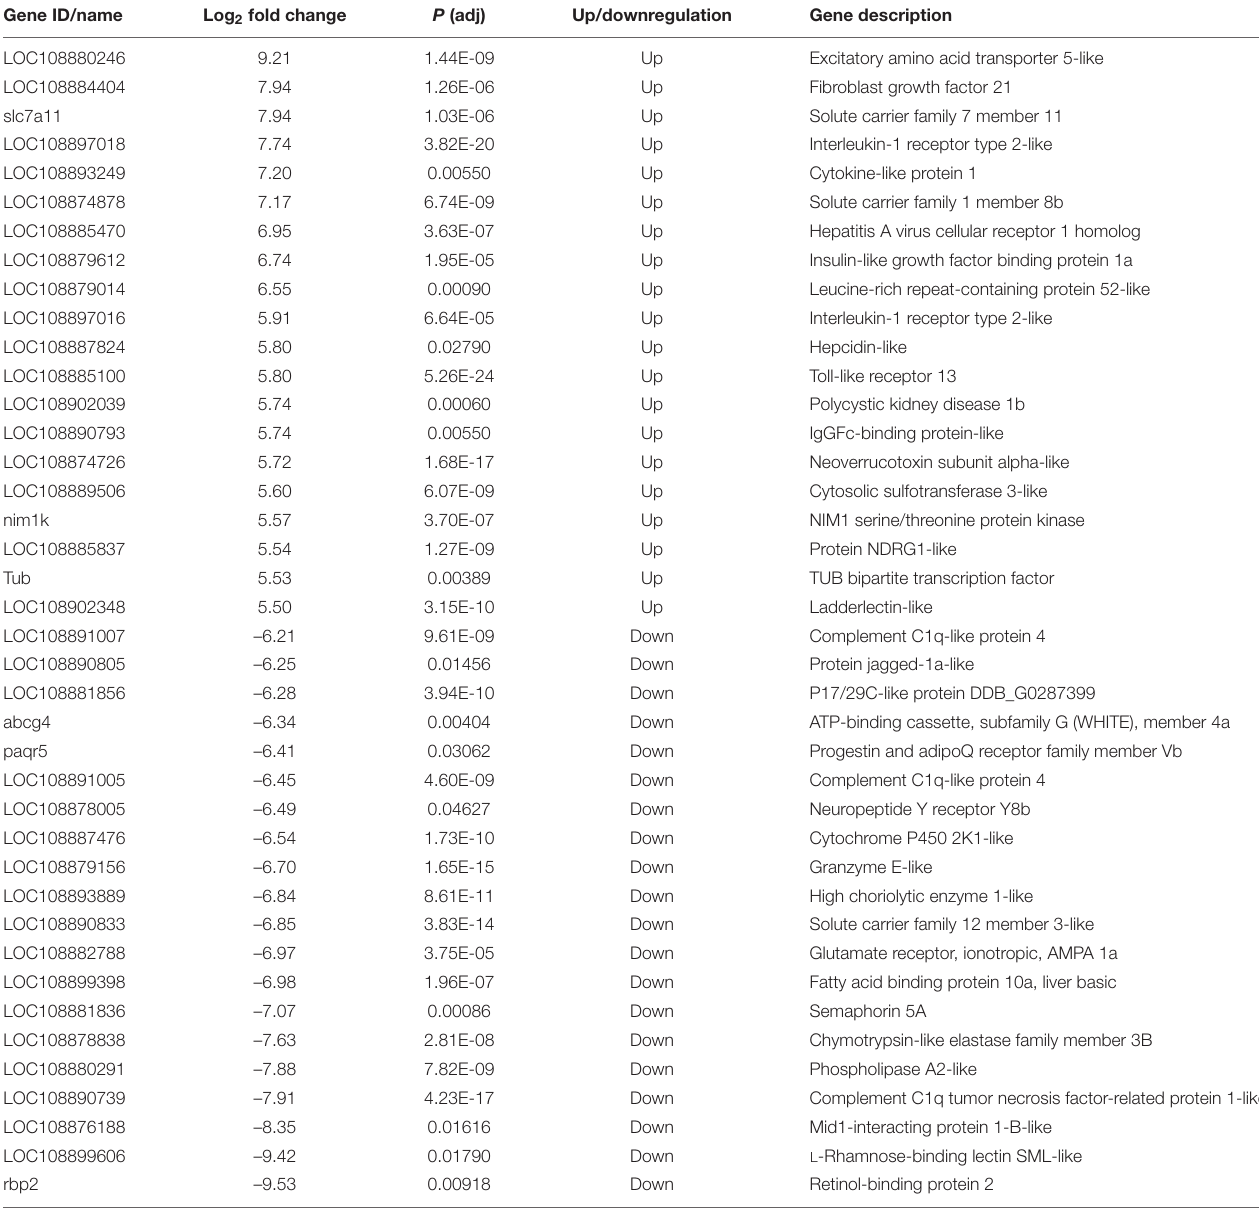
TABLE 2 | The top 20 significantly up- or downregulated genes in liver of sick barramundi.